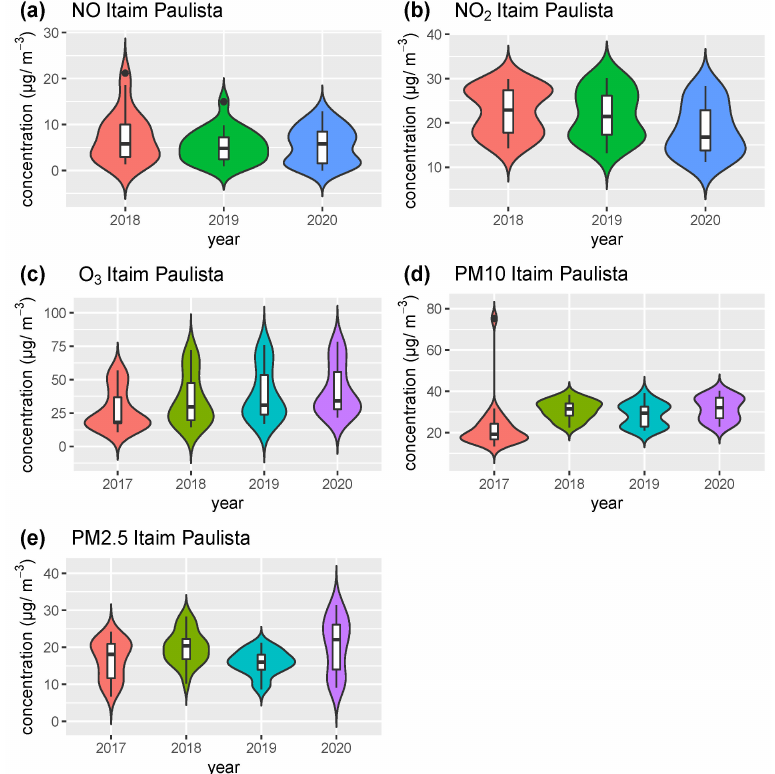
Figure 14. Violin graphs for Itaim Paulista station during April to May of 2017 to 2020 from ground